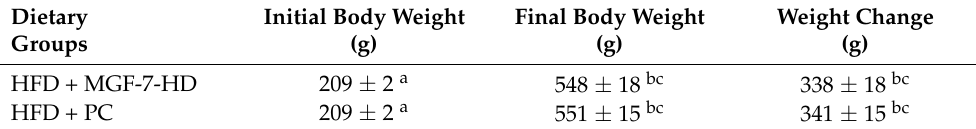
Table 1. Cont . Dietary Groups